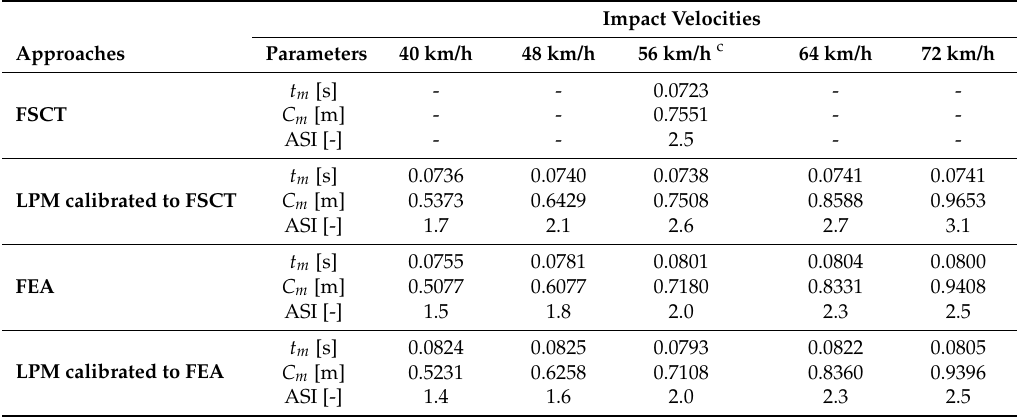
Table 2. Estimated crashworthiness parameters for FSCT, LPM and